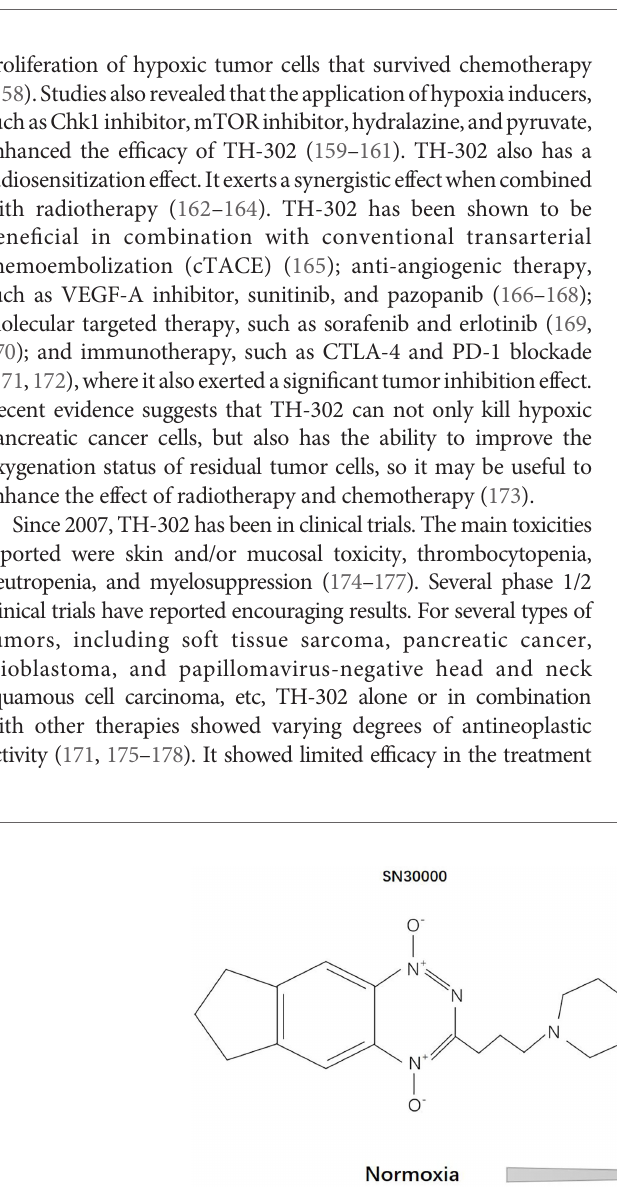
FIGURE 6 | Reductive reaction of TH-302.